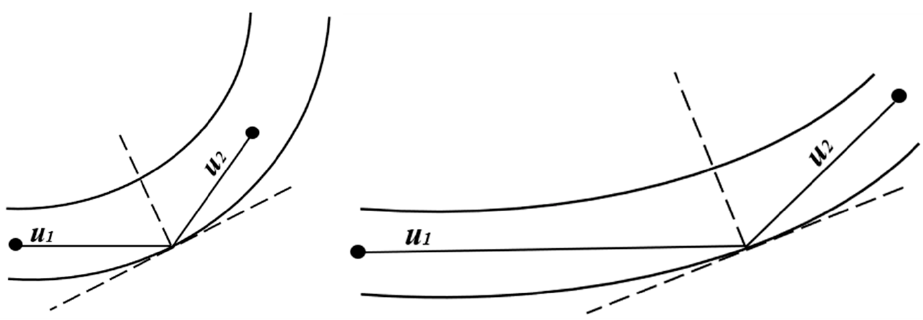
Figure 11. Schematic diagram of solid particle–wall collision at different radii of curvature.